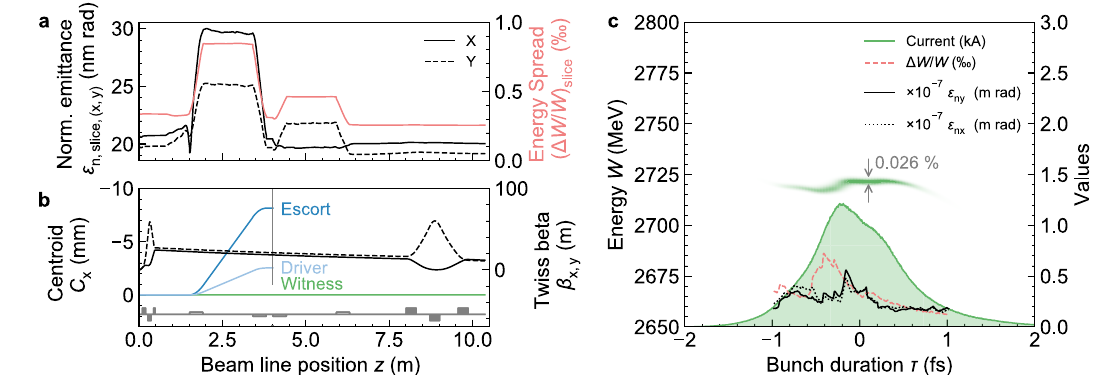
Fig. 3 | Witness bunch transport. a Average transverse slice emittance ε n, slice evolution and average slice energy spread ( Δ W/W ) s during transport through the permanent magnet triplet, the four chicane line dipoles and the electromagnet triplet. b Thecentroidde fl ection C x ofthedriver,escortandwitness(left y -axis)and